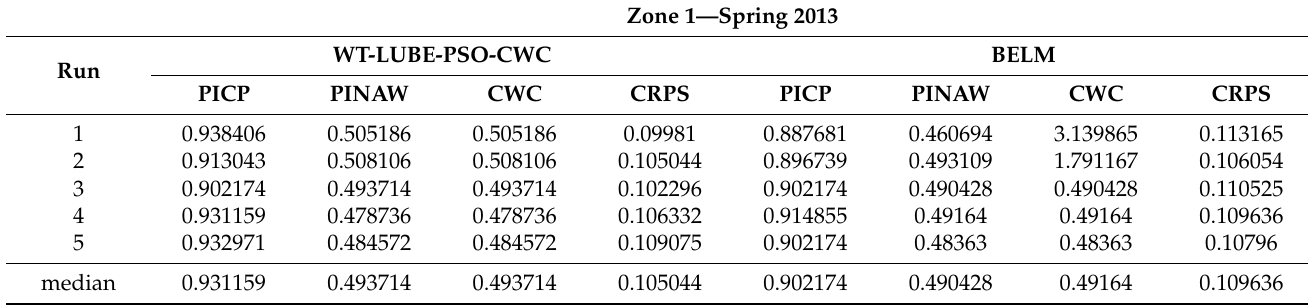
Table 6. Results of the evaluation of 5 training sessions of WT-LUBE-PSO-CWC and BELM models in zone 1 for spring 2013 at the 0.9 confidence